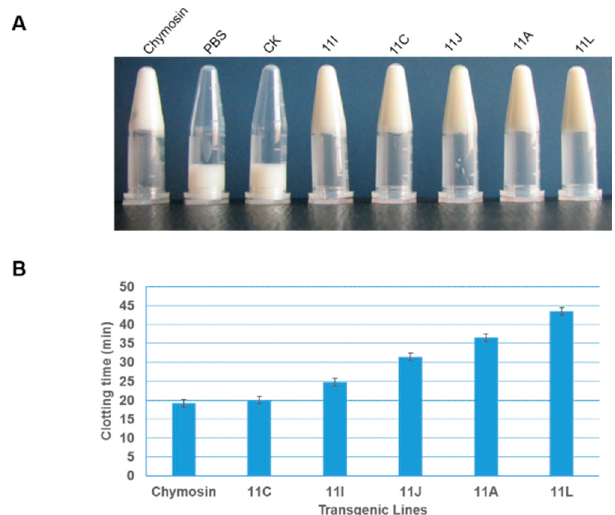
Figure 4. Milk clotting tests for recombinant bovine chymosin. The status of milk clotting ( A ) and the time consumed ( B ) are shown. Chymosin, PBS, and CK represent the commercial chymosin from calf, PBS buffer, and crude TSP from wild-type plant respectively; 11A, 11C, 11I, 11J, and 11L represent crude TSPs from the transgenic plants accordingly. Data of clotting time are collected from three independent repeats.